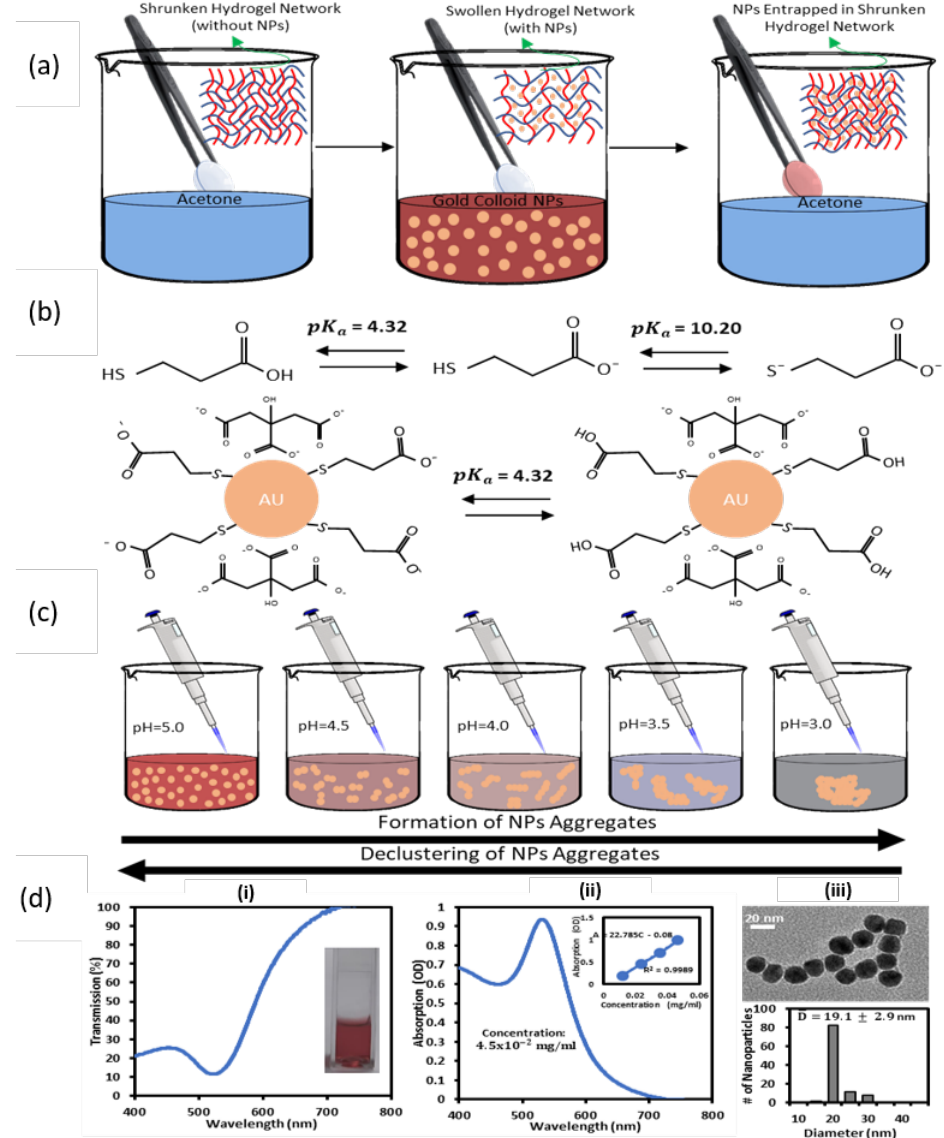
Figure 1. Gold-MPA nanocomposite hydrogel’s synthesis and mechanism of formation. ( a ) Breathing process utilized for loading the nanoparticles into the hydrogel matrix. Protonation of ( b ) MPA (at pK a = 4.32 and pK a = 10.20) and gold nanoparticles protected by MPA (at pK a = 4.32). ( c ) Illustration of pH-dependent reversible colorimetric change of gold colloidal NPs. ( d ) Synthesized gold nanoparticles protected by MPA. ( i ) Transmission and ( ii ) absorption spectra. Inset shows the calibration curve used to determine the concentration of the NPs. ( iii ) TEM of the synthesized gold nanoparticles (top) along with their corresponding size distribution (bottom).